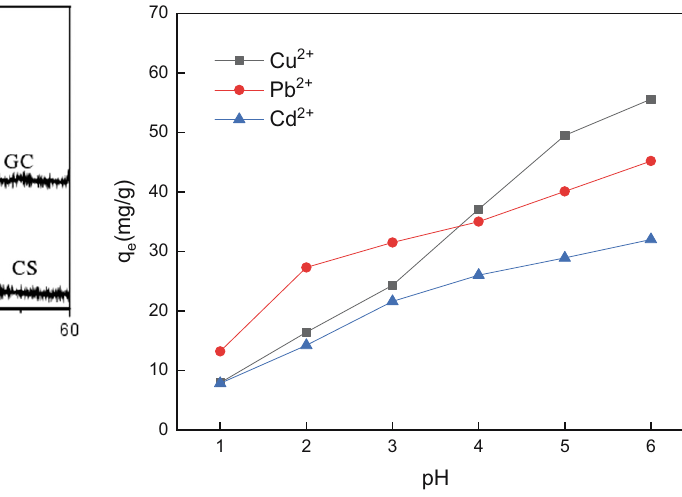
Table 1: BET aperture analysis results Report item